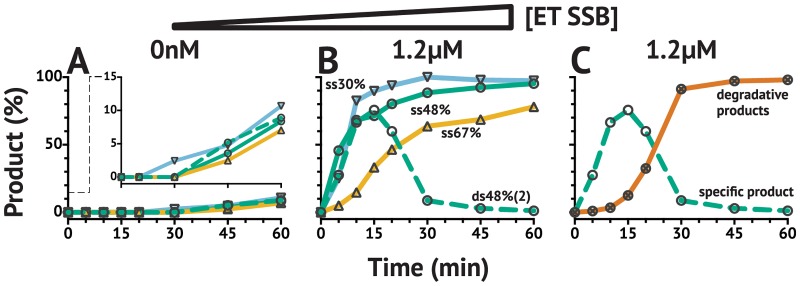
Effect of ET SSB on Pf Ago activity in vitro using 21 nt guides.The addition of ET SSB to Pf Ago increases its rate of activity, but does not affect GC content preference or ability to cleave dsDNA substrates. This is likely due to the reaction being performed at 90 °C where duplex and secondary structure are melted. (A) Pf Ago activity in the absence of ET SSB, and (B) Pf Ago activity in the presence of 1.2 μM ET SSB. (B–C) The decrease in 50%GC dsDNA substrate after 15 min is due to degradation of the product. This only occurs with Pf Ago on dsDNA substrate, and is reminiscent of the apo-form degradation previously described for other pAgos [26, 27]. Single-stranded (ss) and double-stranded (ds; dashed line) substrates along with the corresponding GC contents (▽30%; ○48%; △67%) are labeled in (B). Degradative products are represented by the solid line with ⨂ markers in (C).